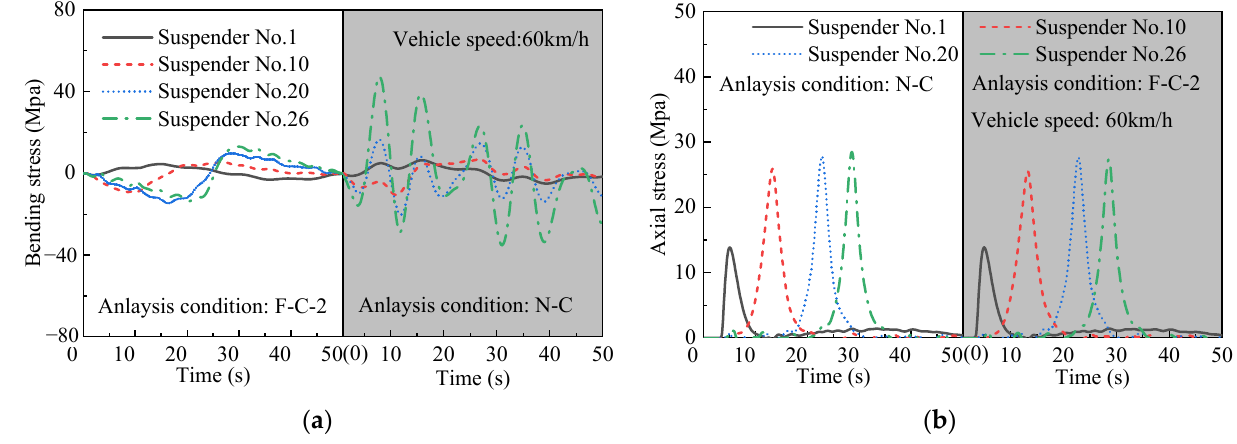
Figure 12. Comparison of suspender stress. ( a ) Bending stress; ( b ) axial stress. Only the bending stress and axial stress of partial suspenders are shown due to layout constraints. The variation of the axial stress of short suspenders is small, whereas the length of short suspenders near the midspan is too small to release stress; the bending stress is greater than long suspenders. The influence of bending stress cannot be neglected in the analysis of suspender degradation. The settlement of flexible buckles considerably reduces the bending stress of suspenders but has minimal effect on the axial stress. The bending stress of short suspenders near suspender no. 26 (midspan) slightly decreases, whereas the long suspenders are almost unaffected. Thus, short suspenders nos. 21–26 are selected as analysis objects. The traffic load is divided into different levels according to traffic density and then used for loading to calculate the structural dynamic response under traffic conditions. Figure 13 shows the suspender stress under the traffic flow at level 5. The time history of axial stress is consistent for different conditions, and the bending stress presents a remarkable difference in that the peak values are greatly reduced.